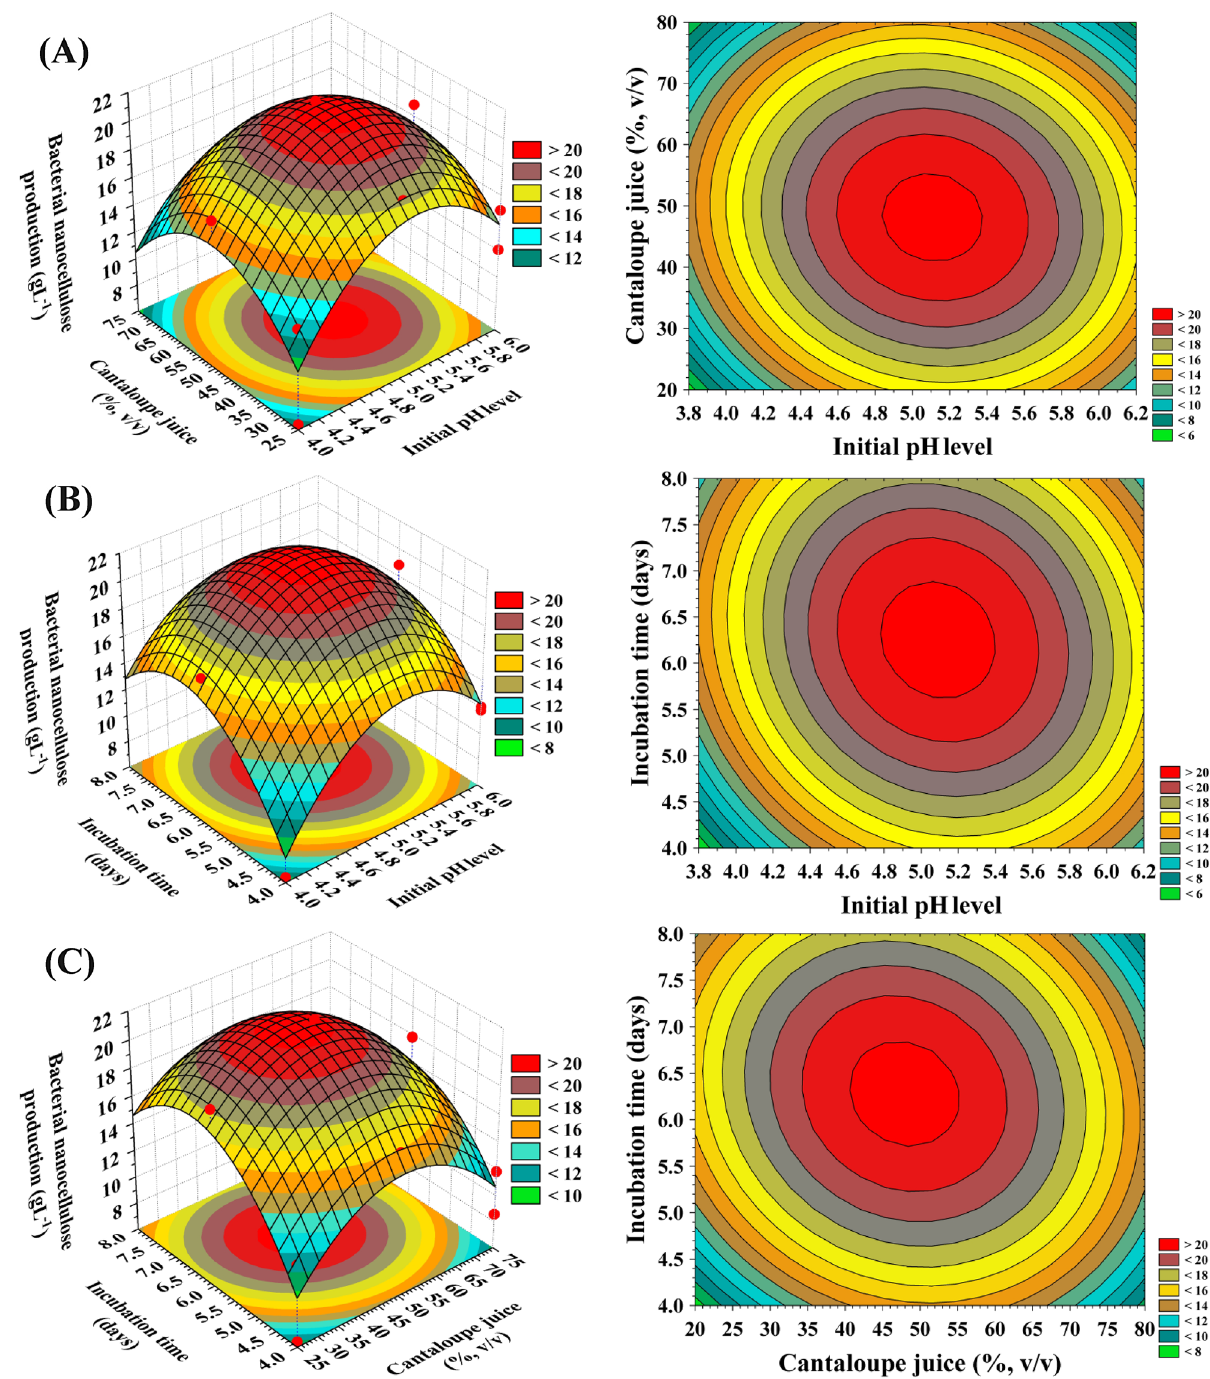
Figure 5. ( A–C ). 3D plots showing the mutual effects of pH (X 1 ), Cantaloupe juice (X 2 ) and incubation time (X 3 ) on BNC